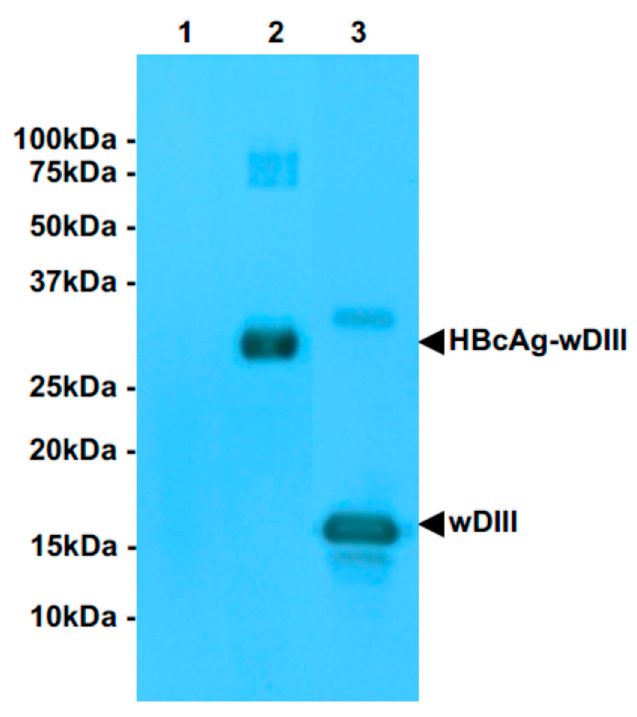
Figure 2. Western blot analysis of HBcAg-wDIII expression in N. benthamiana . HBcAg-wDIII was extracted from leaves and separated on SDS-PAGE gels and transferred onto PVDF membranes. wDIII-specific E16 mAb was used to detect HBcAg-wDIII. lane 1: negative control leaf proteins extracted from un-infiltrated leaves; lanes 2: sample collected 6 DPI from leaves agroinfiltrated with HBcAg-wDIII construct; lane 3: E. coli -produced wDIII as a positive control.